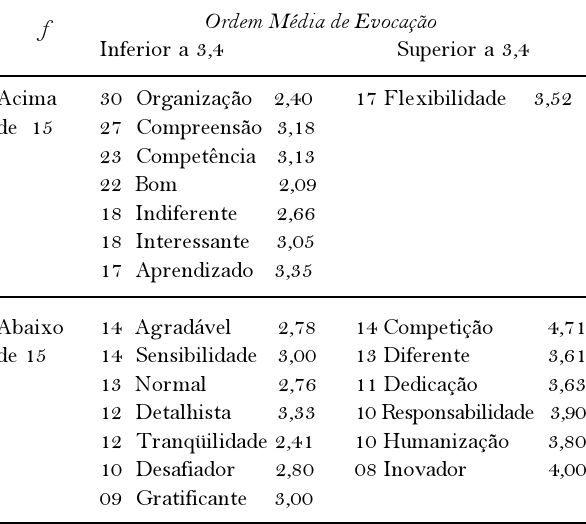
Figura 1 . Prováveis elementos da RS do gerenciamento feminino evocado pelos membros das equipes das mulheres em função da freqüência e da ordem de evocação ( N =146). Nº Total de evoca- ções = 850; Nº Total de palavras diferentes =